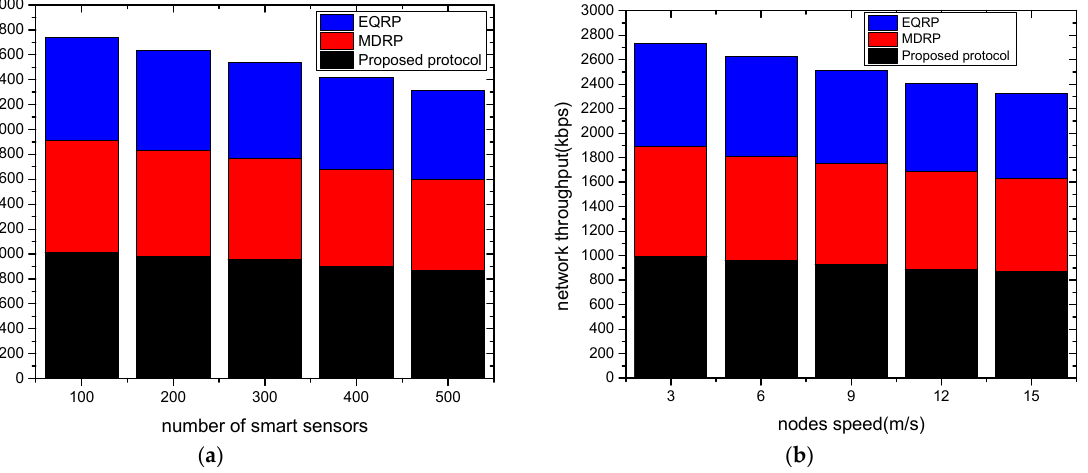
Figure 4. Varying smart sensors and node speed levels in terms of network throughput. ( a ) Network throughput and varying sensors; ( b ) network throughput and varying node speed.